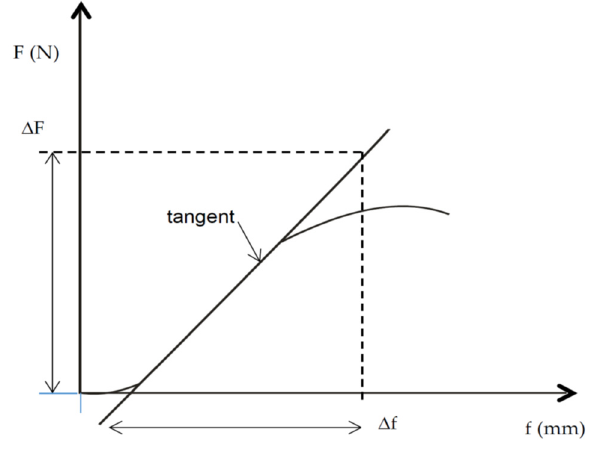
Figure 7. The initial slope of the bending force-deflection diagram. Adapted from